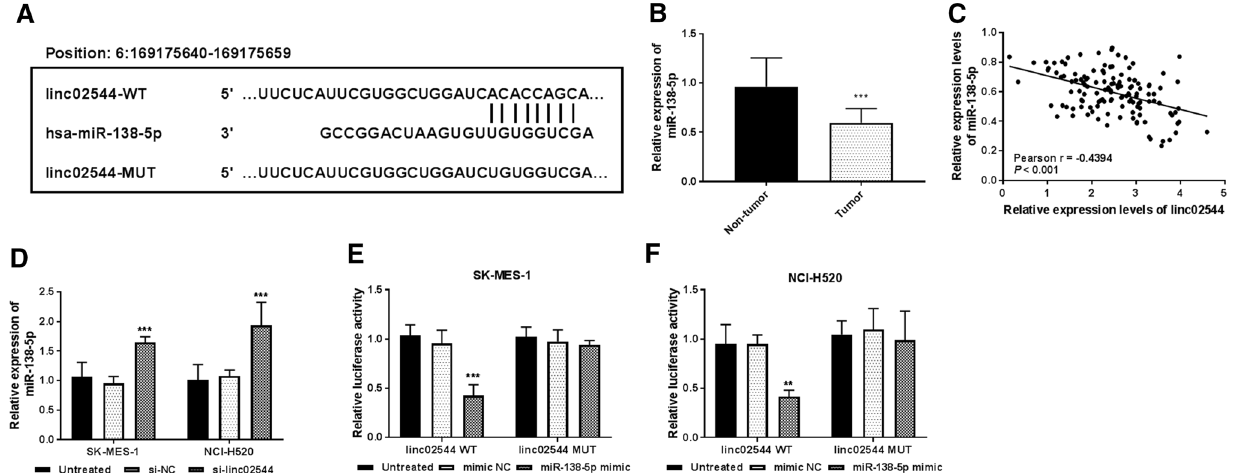
Fig. 4 miR-138-5p, a target of linc02544. A The putative binding sites between linc02544 and miR-138-5p. B The miR-138-5p levels in LUSC tissues and corresponding adjacent non-tumor tissues were measured by RT-qPCR. C Pearson’s linear regression analysis confirmed the neg- ative correlation between linc02544 expression and miR-138-5p (r = − 0.4394, P < 0.001). D The expression of miR-138-5p was increased in SK-MES-1 and NCI-H520 cells after transfecting with si-linc02544. The interaction between linc02544 and miR-138-5p was determined by luciferase reporter assay in SK-MES-1 ( E ) and NCI-H520 cells ( F ). ** P < 0.01, *** P <